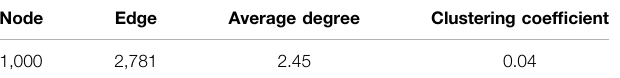
TABLE 2 | Cellular network statistical